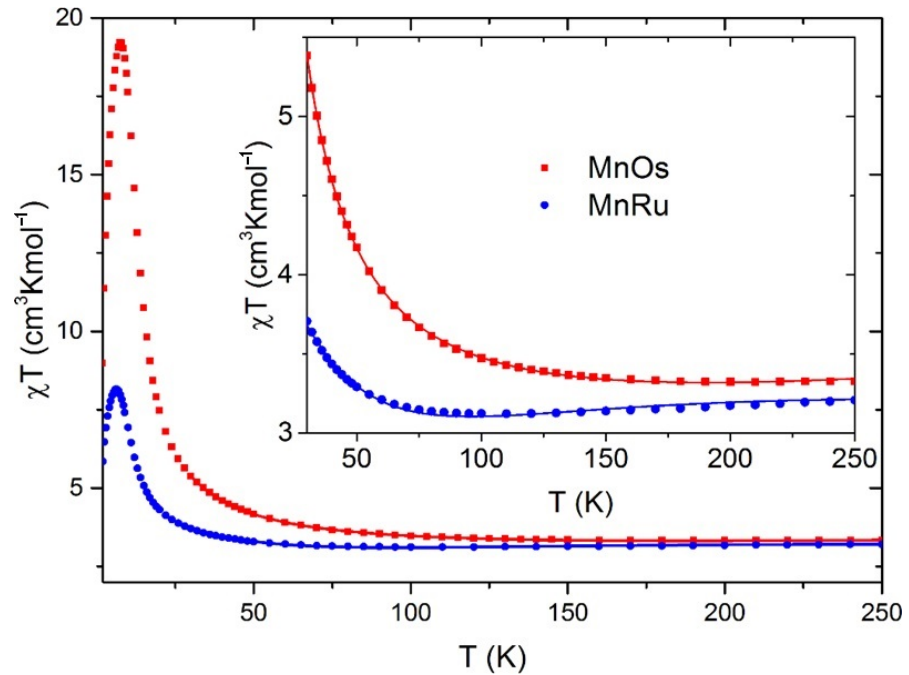
Figure 3. Magnetic susceptibility of 1 (red) and 2 (blue) in 1 kOe; insert: lines were fitted according to the Seiden’s model.